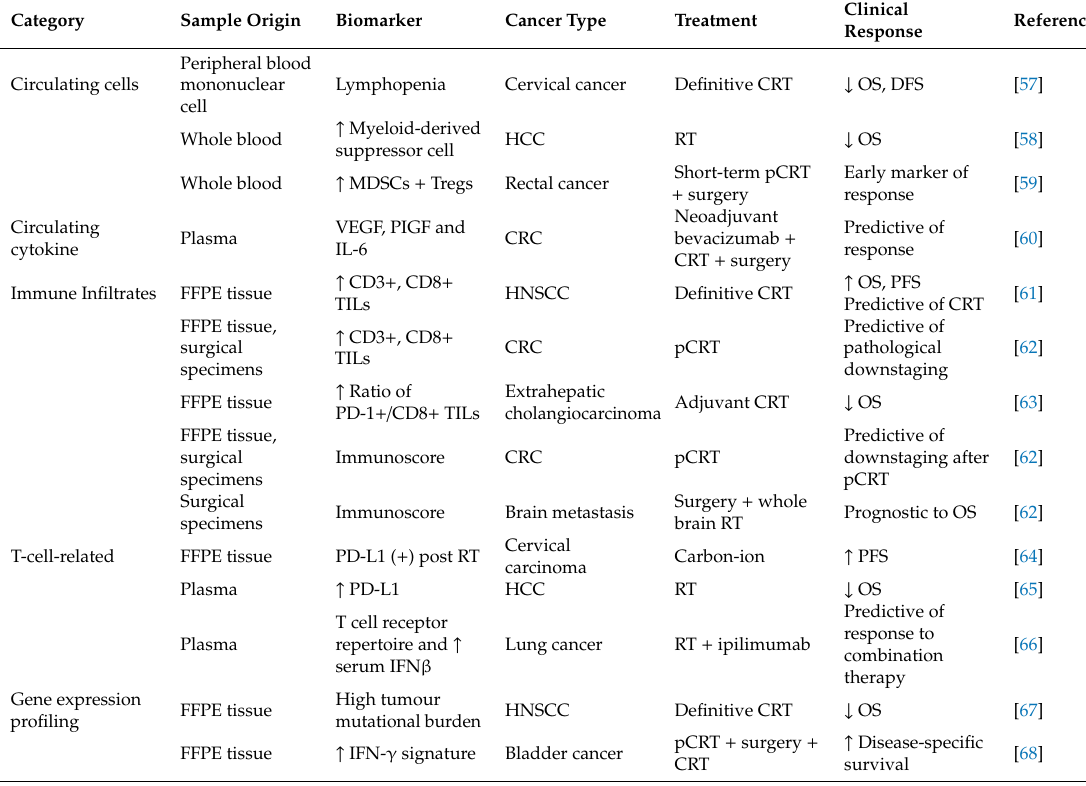
Table 1. Clinical studies on immune-related biomarkers in radiotherapy-based